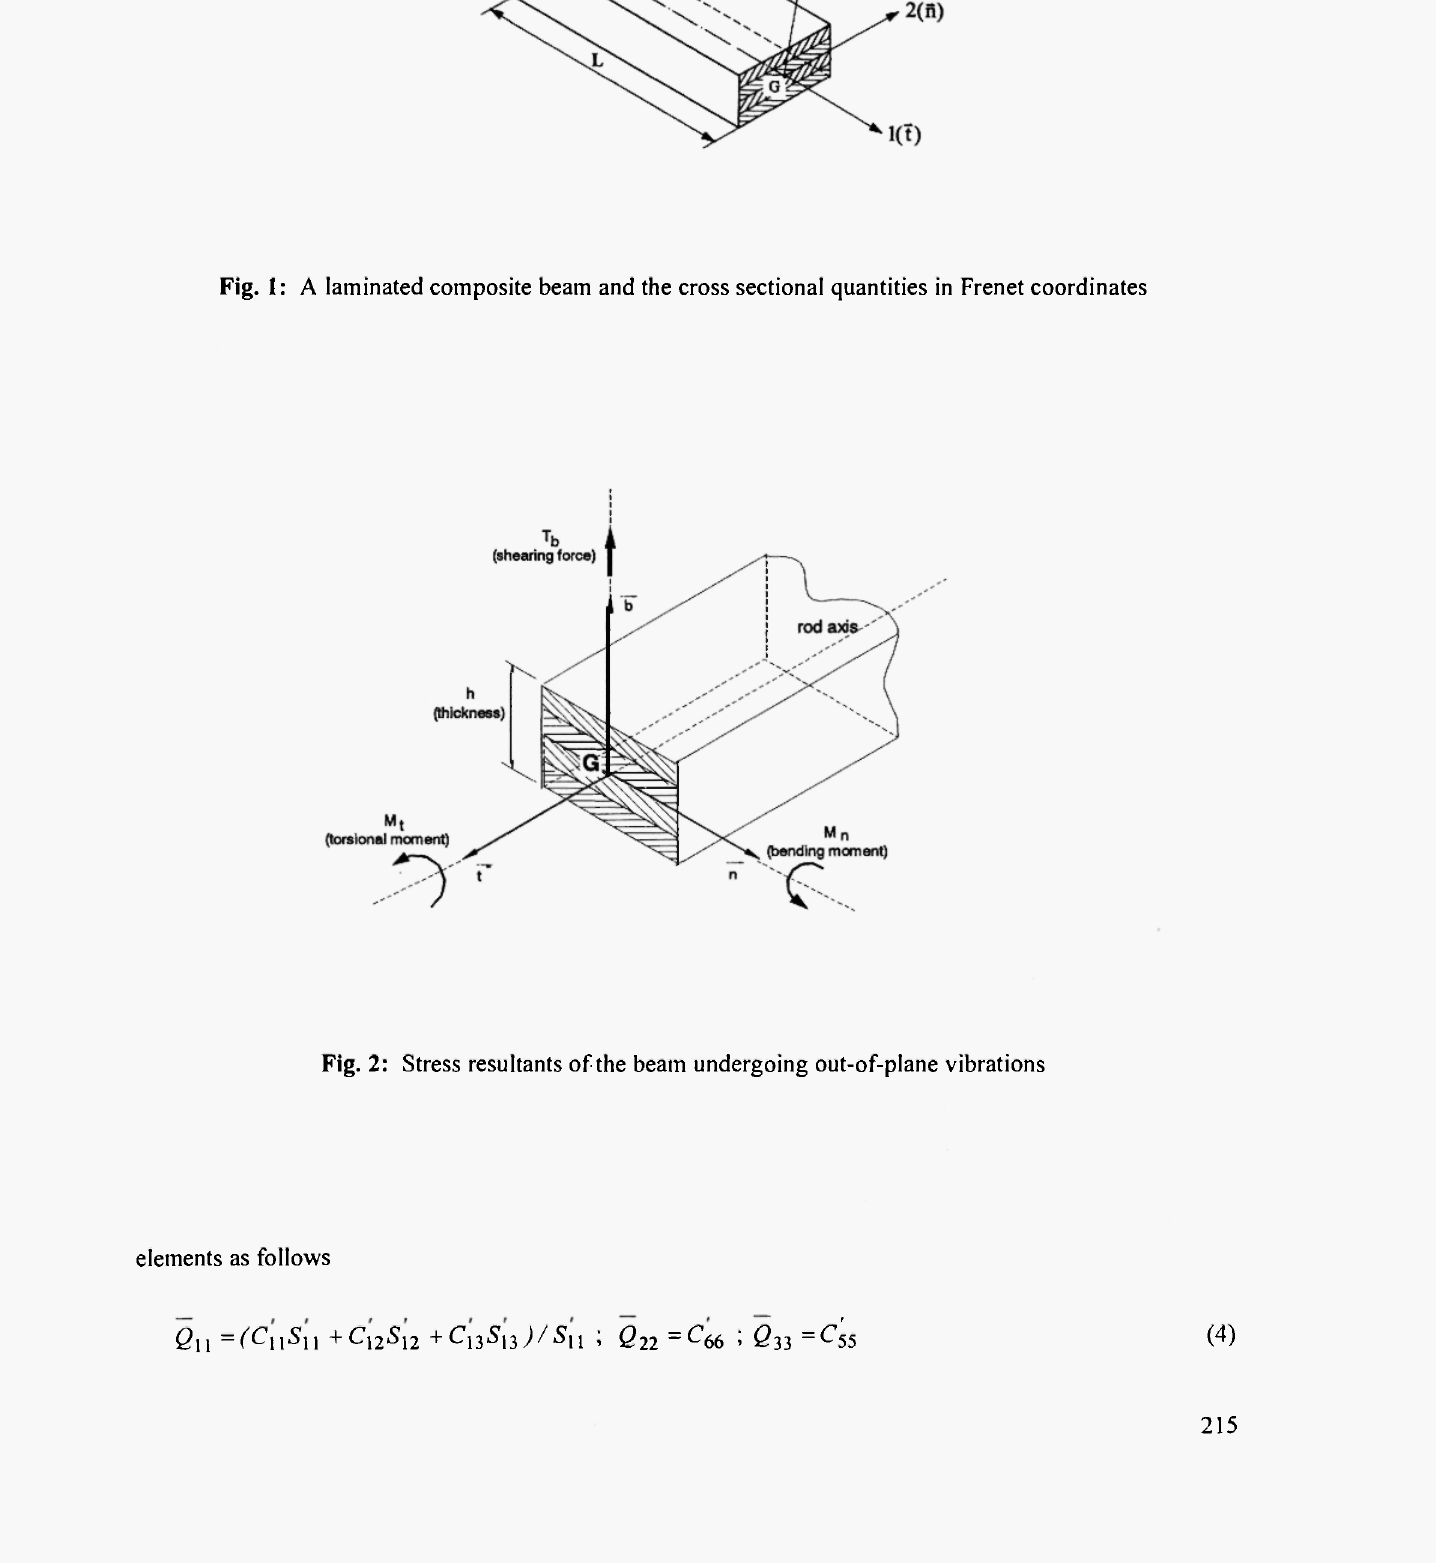
Fig. 1: A laminated composite beam and the cross sectional quantities in Frenet coordinates